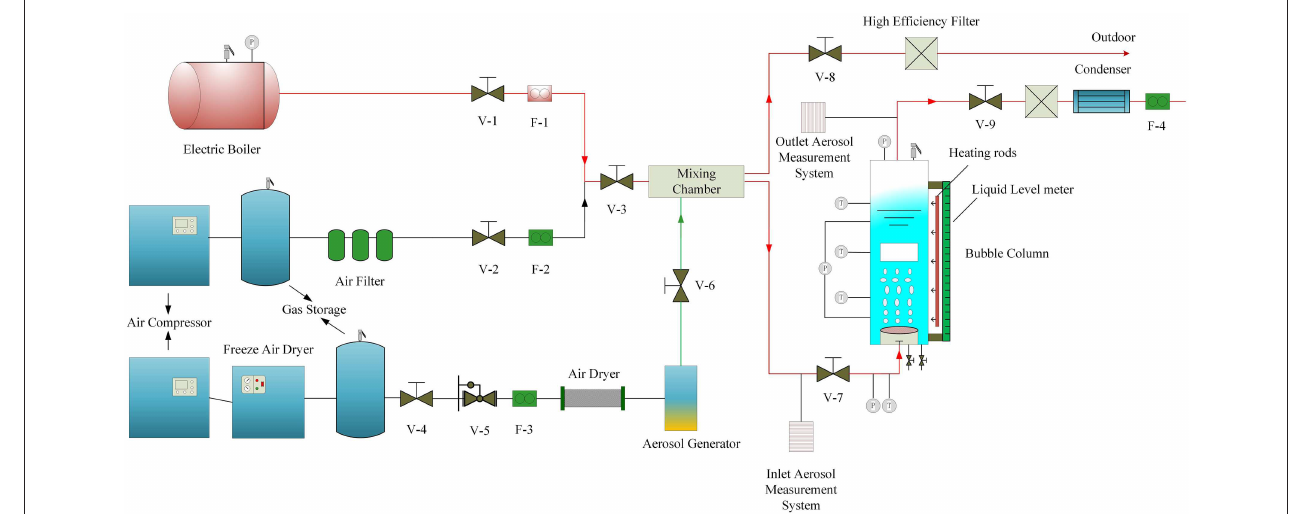
FIGURE 1 | Schematic of the experimental setup.